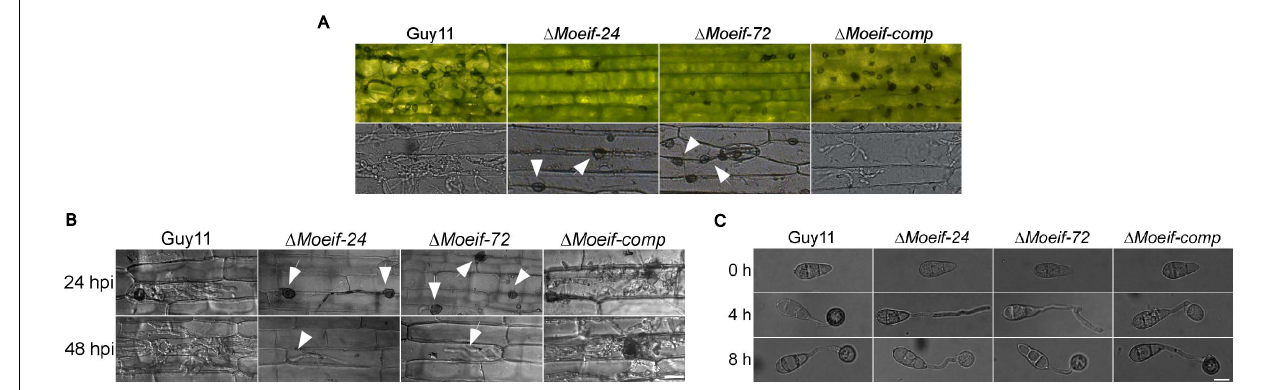
FIGURE 6 | Contribution of MoeIF4E3 for invasive growth of M. oryzae in host tissues. (A) Development of appressorium-like structures and hyphal mediated penetration by the MoeIF4E3 mutants and wild-type strain inoculated on barley leaves at 48hpi. Scale bar, 20 µ m. (B) In vivo penetration and consequent sheath tissue- colonization activity was assessed using fluorescence microscopy at 24- and 48-hpi. (C) Germination and appressorium formation activity by conidia obtained from the respective mutants and the wild type on an artificial hydrophobic surface. Leaf-sheaths of susceptible rice cultivar CO39 were inoculated with conidia suspension of the same strains used for hyphal mediated penetration on barley leaves. Bar 40 µ